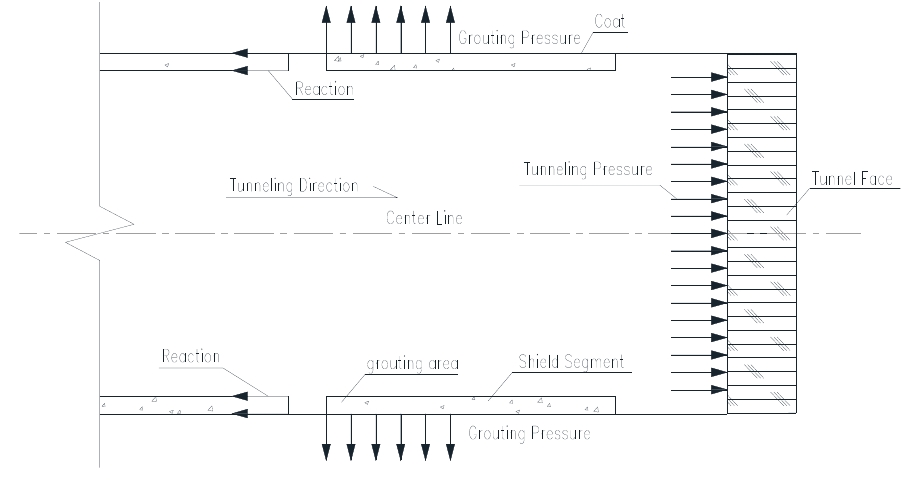
Figure 6. Sketch of shield excavation loads.